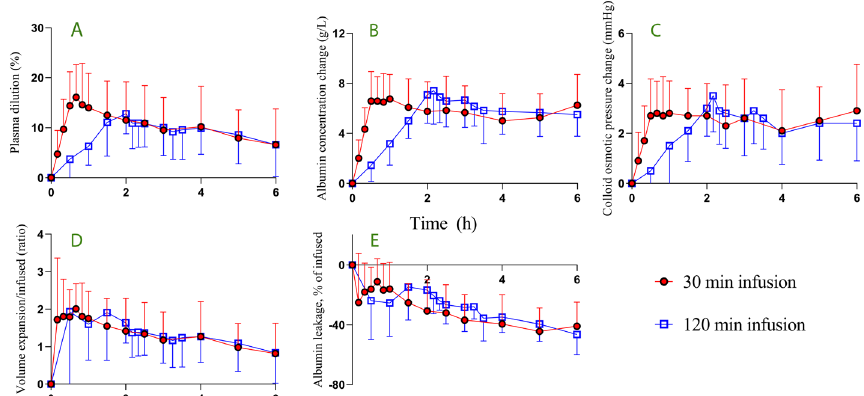
Fig. 3 Mass balance. A Plasma dilution. B Changes in plasma albumin concentration. C Changes in plasma colloid osmotic pressure. D Plasma volume expansion divided by the infused volume of 20% albumin. D Capillary leakage of albumin expressed as a percentage of the infused amount of albumin. All data are the mean